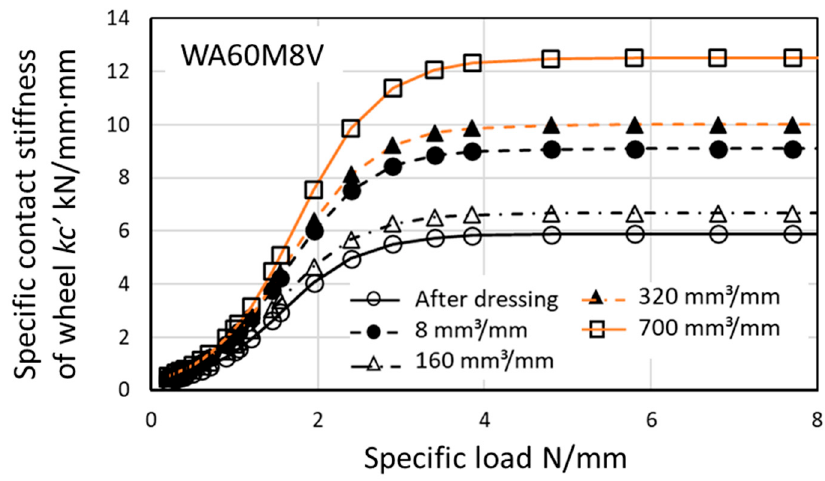
Figure 20. The e ff ect of accumulative specific material removal on contact sti ff Figure 20. The effect of accumulative specific material removal on contact stiffness.